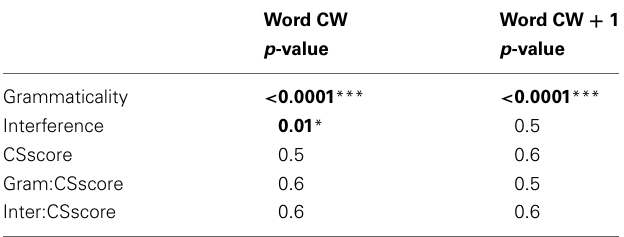
FIGURE 7 | The interaction between interference effect and CS scores in acceptance rate, for subject-verb agreement errors. (A) Correlation between each individual subject’s difference scores between their interference condition and the plain unlicensed condition ( Y -axis: acceptance rate of Interference—acceptance rate of Ungrammatical) and their CS scores ( X -axis: CS scores). (B) Acceptance rate for each condition plotted separately for the high and low CS groups. Table 8 | Number agreement RTs: fixed effects from the linear mixed effect